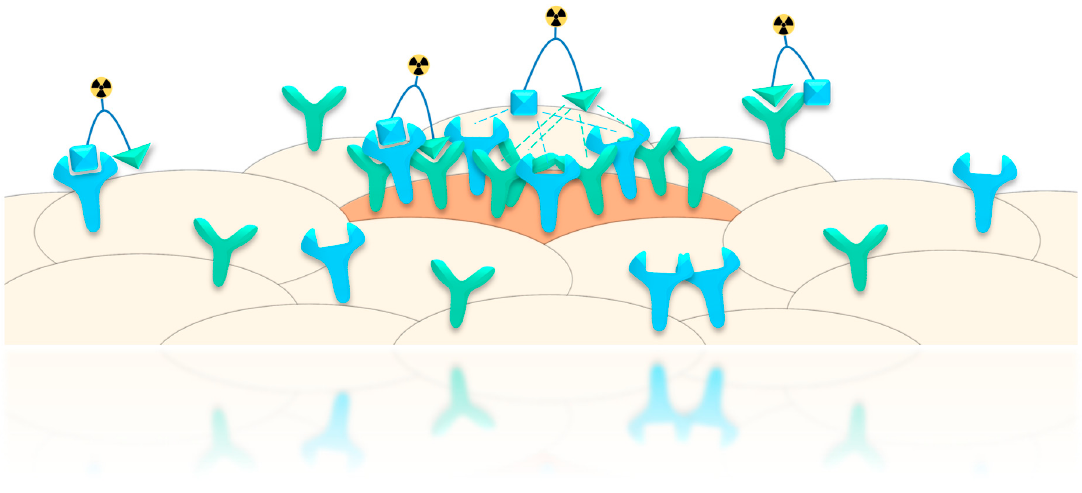
Figure 3. Schematic depiction of increased tumor specificity of heterobivalent binders achieved by concomitant binding to malignant cells overexpressing both receptor types. On benign cells, the target receptors are expressed on a low level, only enabling binding of one of the peptides of the heterodimer, resulting in low target binding being comparable to that of a monospecific peptide. On the malign cell, a higher density of target receptors is available compared to healthy cells, allowing for concomitant binding with higher avidity, resulting in higher targeting specificity.